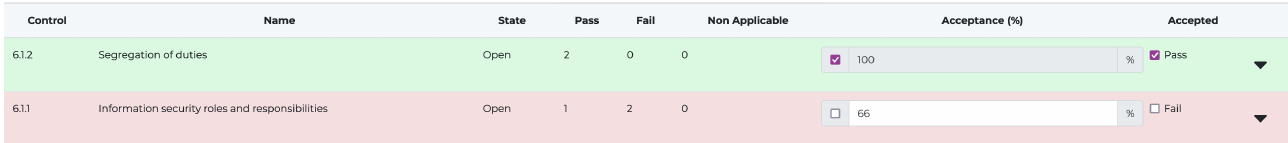
Figure 7. Results from the Type 2 audit, showing both interventions (the first and the second one).